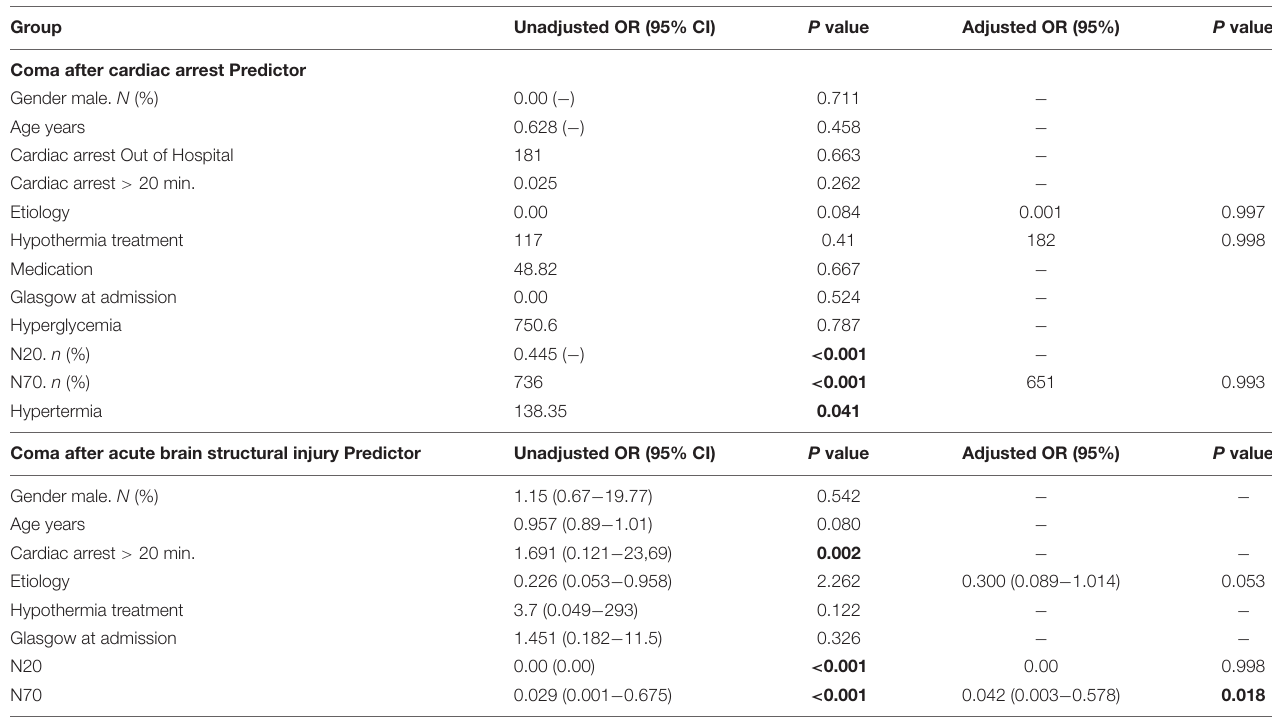
TABLE 3 | Logistic regression-modified Glasgow coma scale and predictor of good outcome in patients with coma after cardiac arrest (CA) and coma after acute brain structural injury